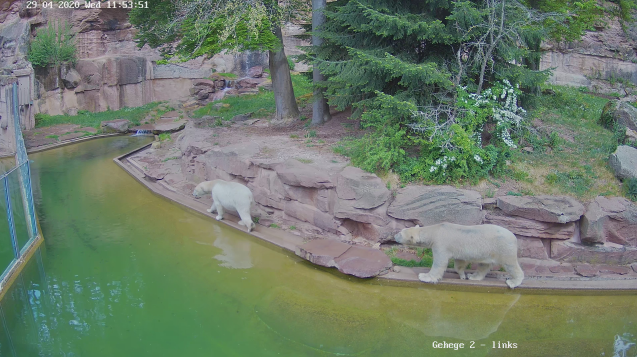
Figure 2. Example picture taken with one of the three cameras. Both animals are walking in one of the two outdoor enclosures. The polar bear on the left is Vera, the one on the right is